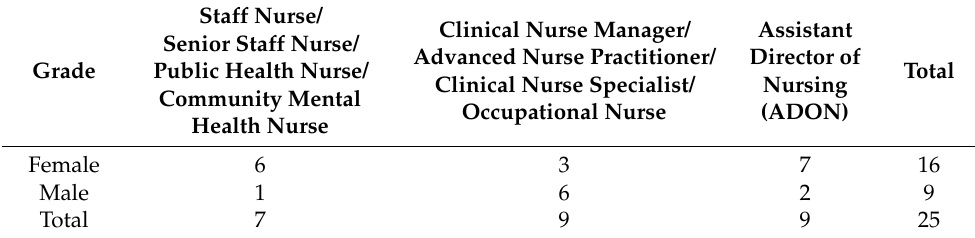
Table 1. Staff grade of participants.